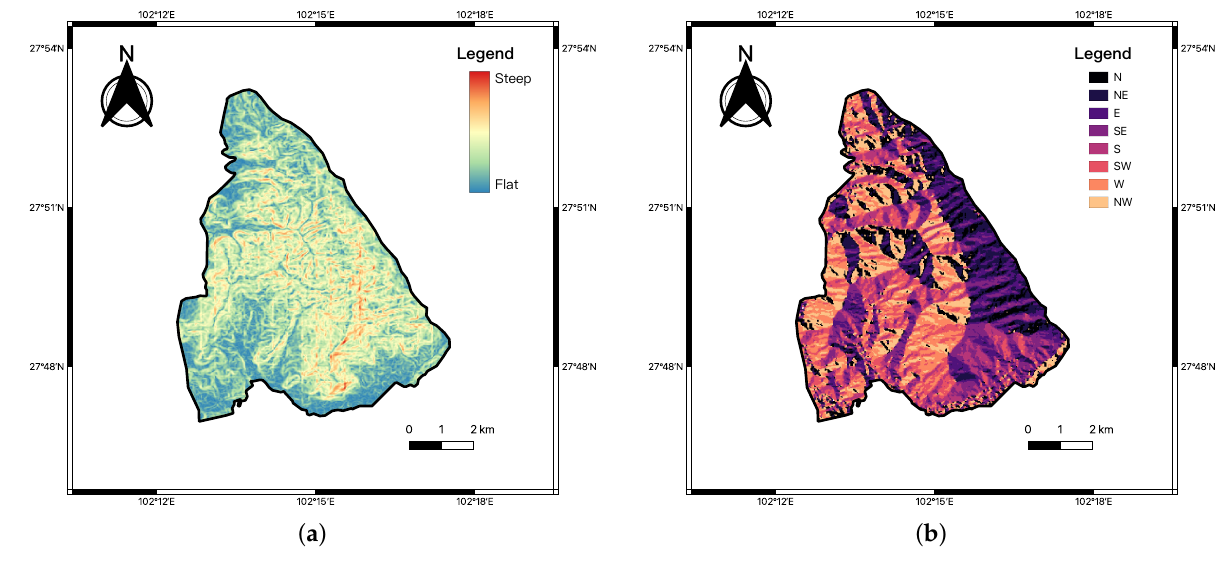
Figure 6. Topography; ( a ) Slope; ( b )